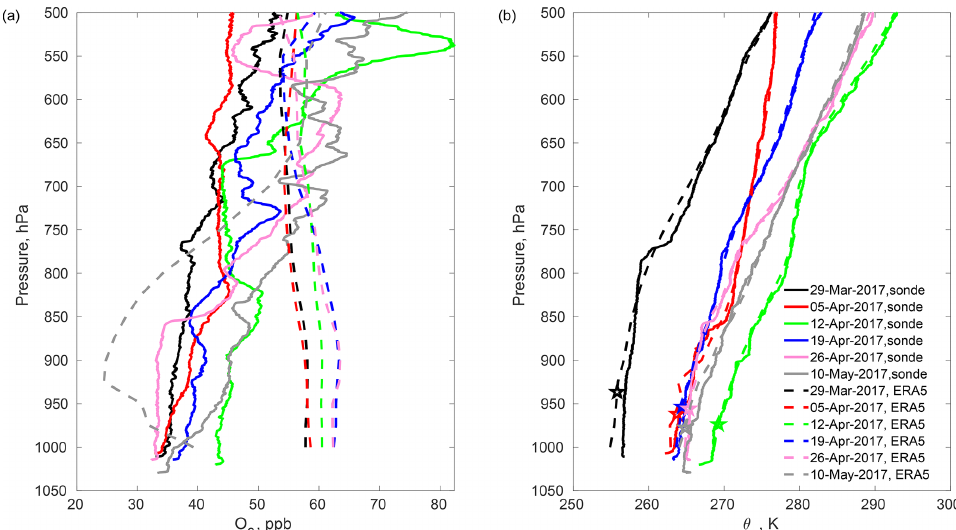
Figure 4. Vertical profiles of O 3 (a) and virtual potential temperature (b) from O 3 sondes and ERA5 reanalysis data. O 3 sonde profiles are shown with solid lines, and ERA5 profiles are shown with dashed lines. The planetary boundary layer height (PBL) in the ERA5 data is plotted with stars on the virtual potential temperature profiles from the reanalysis.